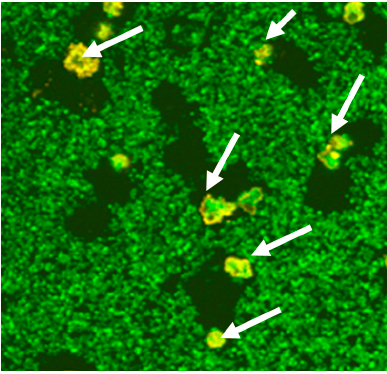
Figure 2. Staphylococcus epidermidis biofilms were grown (green). Neutrophils (arrows) attacked and phagocytosed the biofilm, as seen by the spaces in between the biofilm.